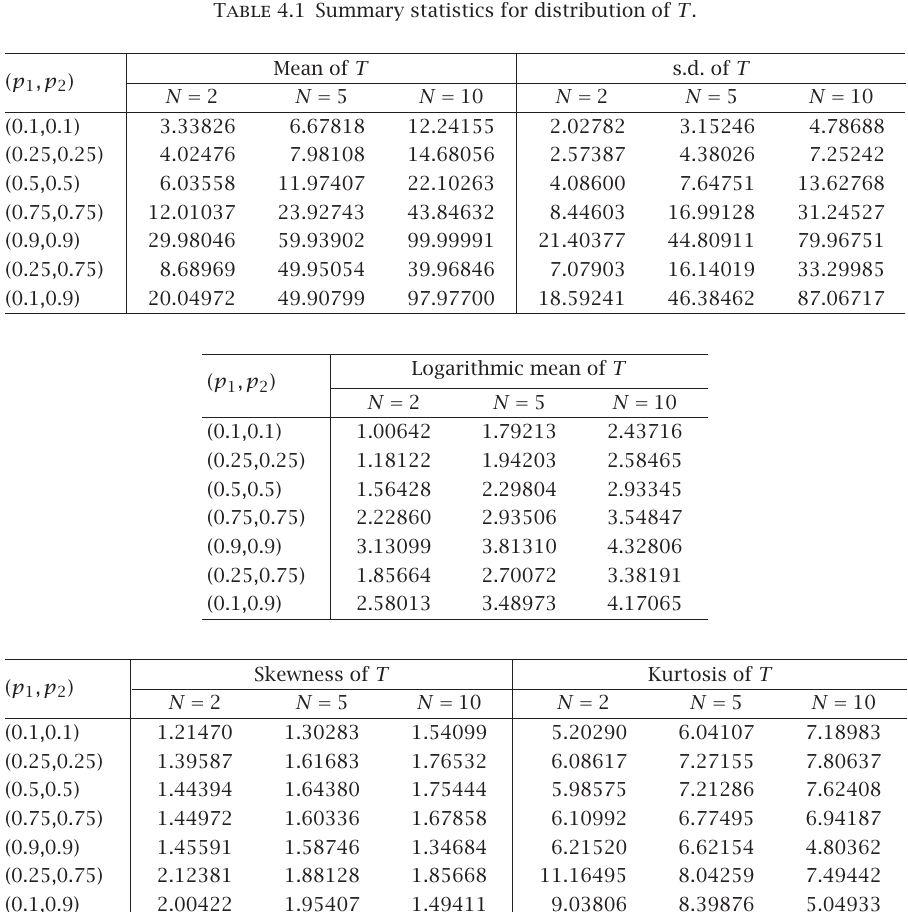
Table 4.1 Summary statistics for distribution of T